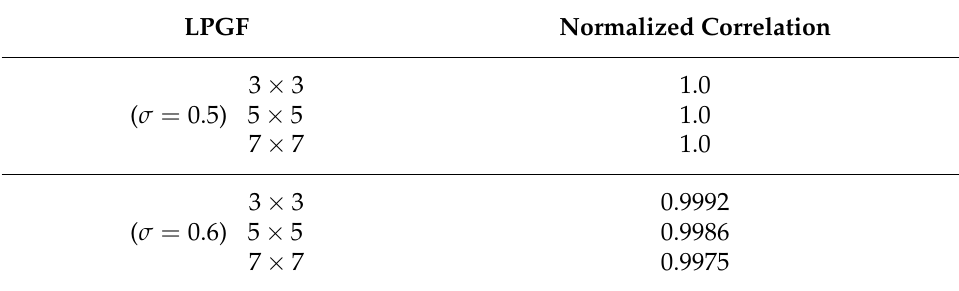
Table 5. Robustness evaluation measured in terms of normalized correlation after low-pass Gaussian filtering for Mandrill